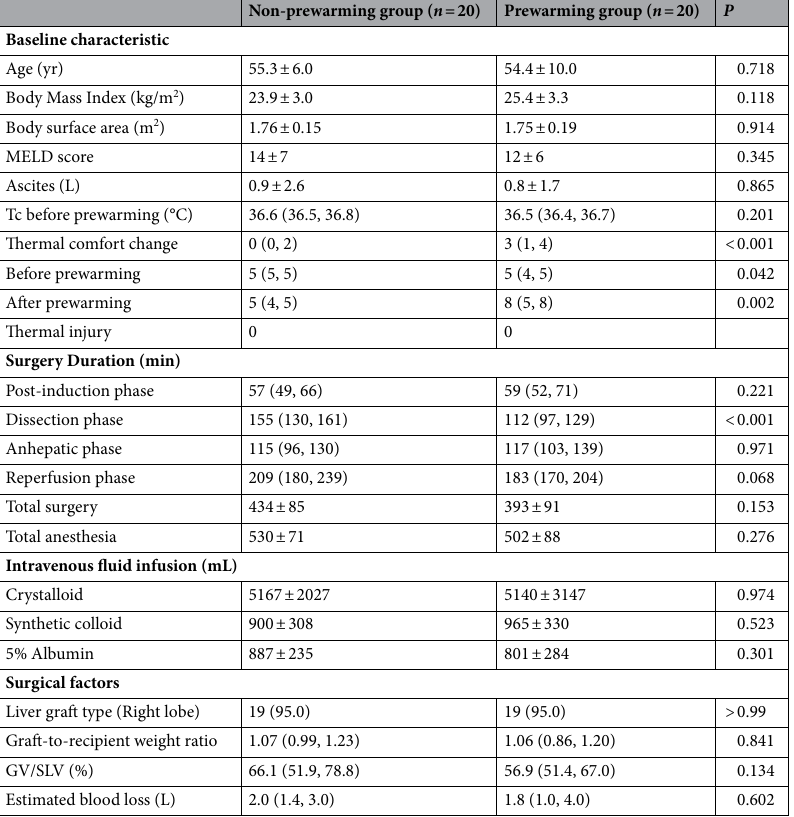
Table 1. Demographic and surgical factors of the patients undergoing liver transplantation. Data are presented as mean (standard deviation) or median (25th percentile, 75th percentile) or frequency (%). GV/SLV, graft volume to standard liver volume ratio; MELD, model for end-stage liver disease; Tc, core